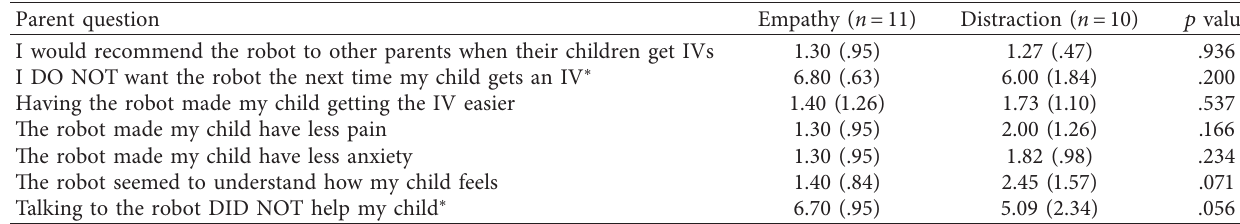
Figure 4: Observed pain scores over time. (a) Mean scores on the FLACC scale over time, showing increased pain at time-point 2 (IV insertion), which is lowest in the empathy group. (b) Mean scores on the CHEOPS scale over time in the same pattern. Table 2: Parent satisfaction questions for robot